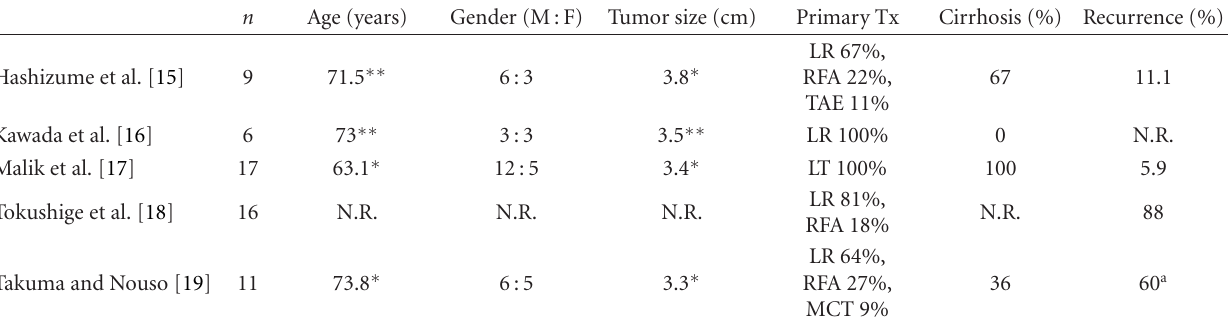
Table 2: Surgical series of NASH-associated HCCs ( ≥ 5